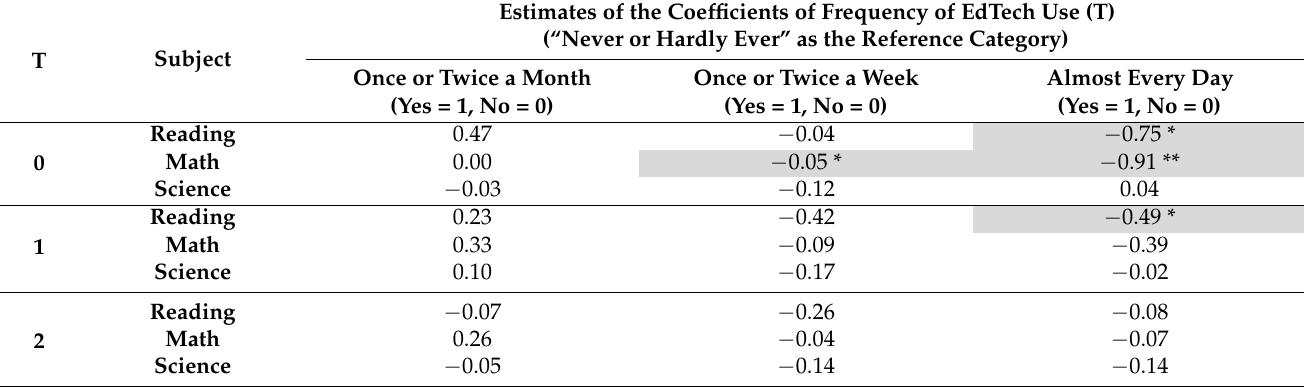
Table 4. Estimates of the coefficients of frequency of EdTech use (T) in Model